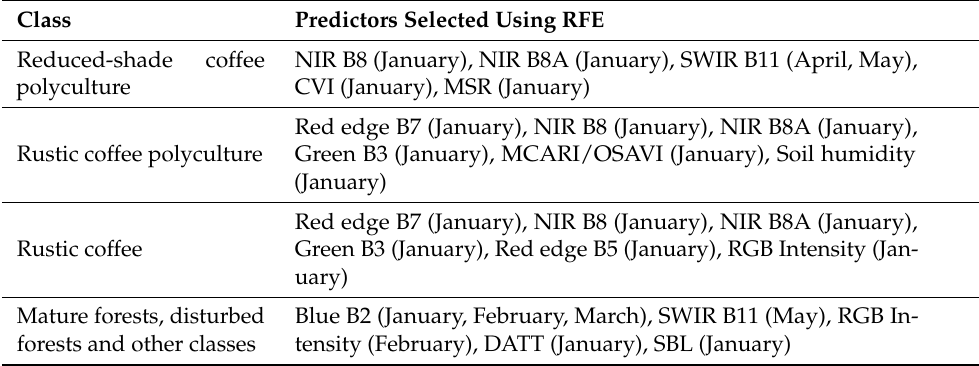
Table 4. Predictors selected for each classification process. NIR = Near infrared, SWIR = Short-wave infrared, Bi = band